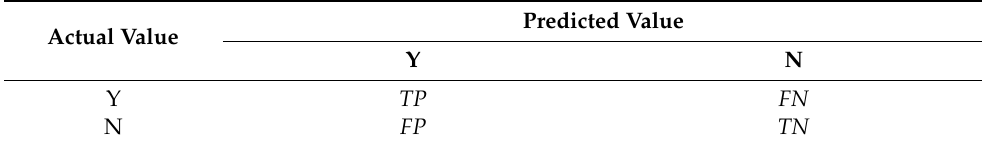
Table 2. Confusion matrix. P: Positive; N: negative; TP : true positive; FP : false positive; FN : false negative; TN : true negative.